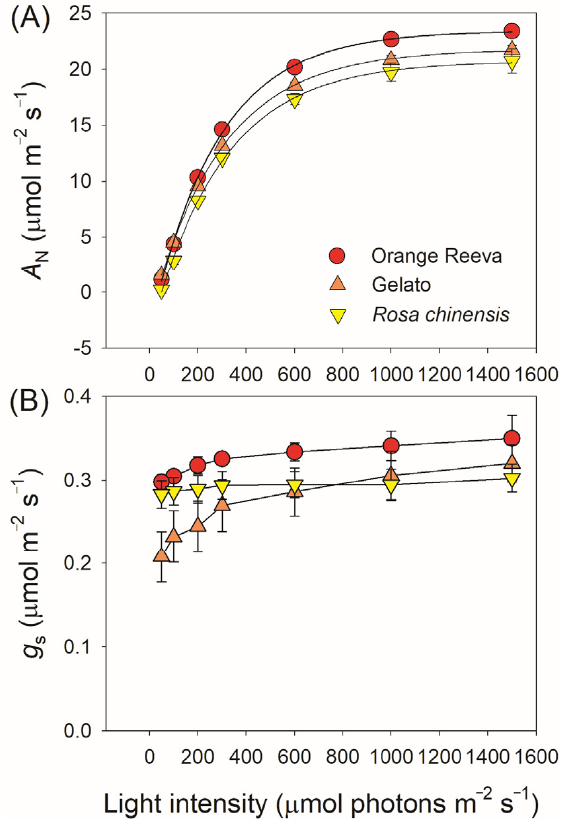
Figure 1. Light intensity dependence of leaf net CO 2 assimilation rate ( A N ) ( A ) and stomatal conductance ( g s ) ( B ) in two modern rose cultivars (Orange Reeva and Gelato) and the old Chinese rose plant Rosa chinensis . Data are means ± SE ( n = 5).